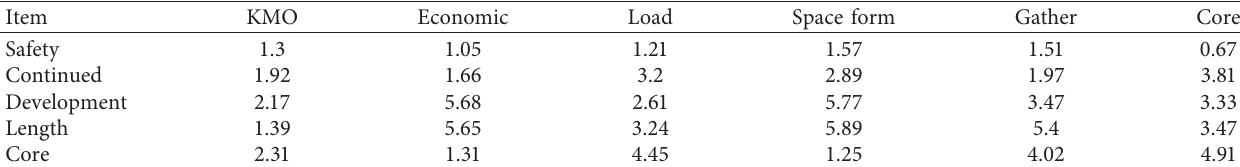
Table 6: Relative index of economic evaluation of high-speed railway system.